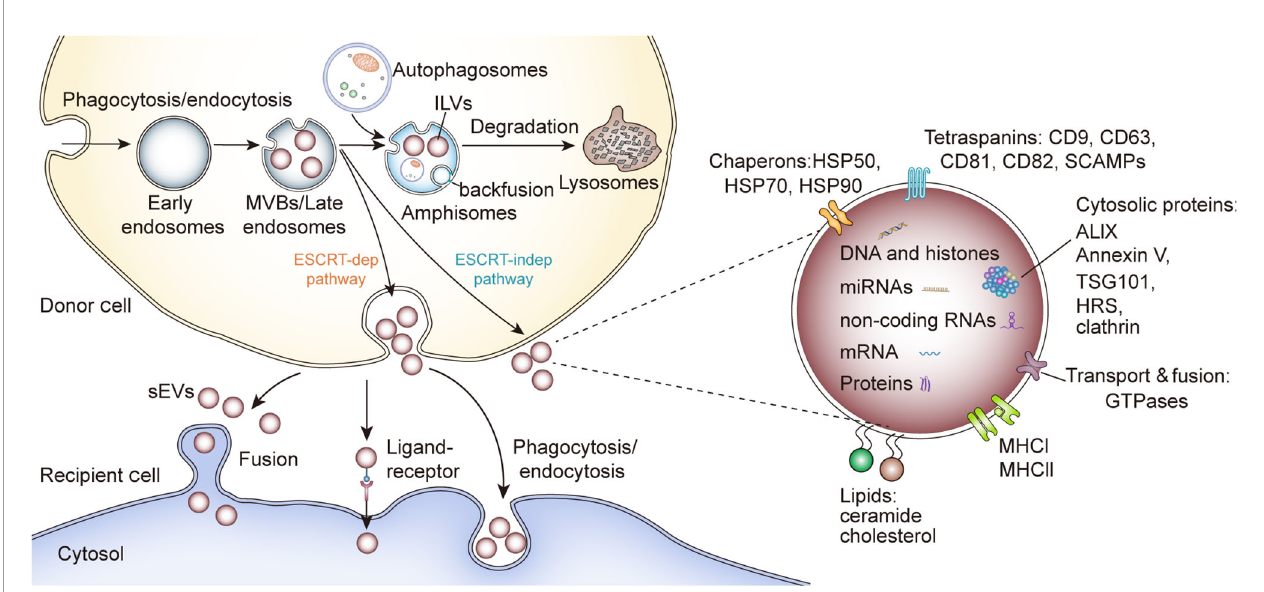
FIGURE 1 | sEV biogenesis, cargo contents and uptake. HSP, Heat shock proteins; SCAMPs, Secretory carrier membrane proteins; ALIX, Apoptosis-linked gene 2 – interacting protein X; HRS, Hepatocyte growth factor-regulated tyrosine kinase substrate; TSG101, Tumor susceptibility gene